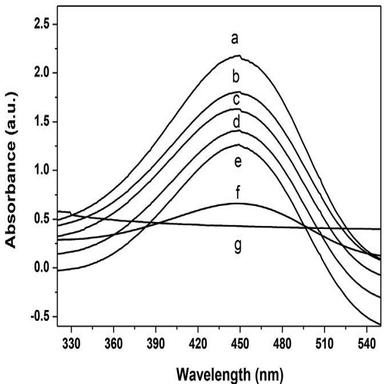
UV-vis spectra of P3HT-MWCNT prepared by click chemistry method (solvent: chloroform): (a) P3HT; (b) physical blend of P3HT and 1 wt% MWCNT; (c) P3HT and 5 wt% physical blends of MWCNT; (d) physical blends of P3HT and 10 wt% MWCNT; (e) physical blends of P3HT and 20 wt% MWCNT; (f) P3HT-MWCNT; (g) MWCNT.